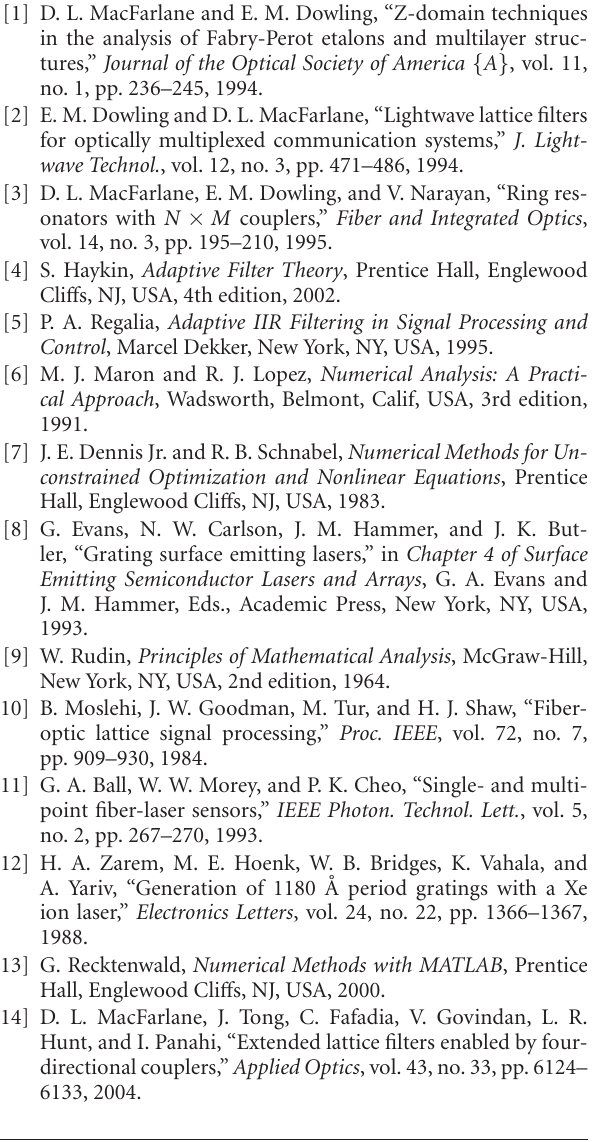
Table 3: Sensitivity of filter parameters respective to